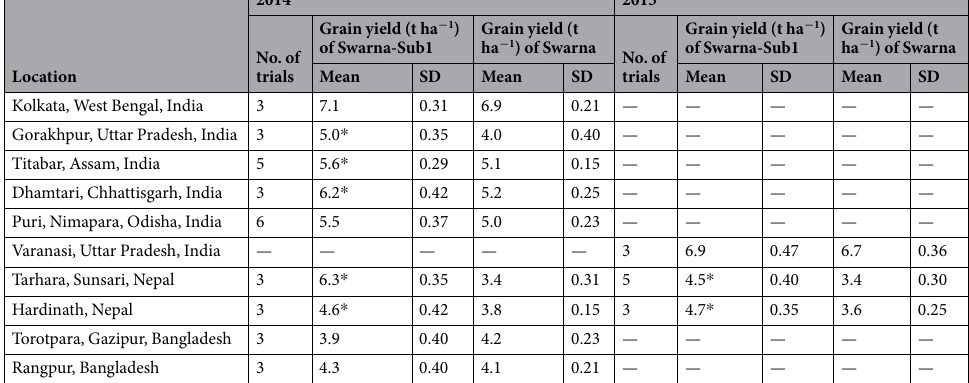
Table 1. Comparisons of grain yield of Swarna-Sub1 and Swarna in head to head trials during the wet seasons of 2014 and 2015. * Indicates that the grain yield is significantly higher than the parental variety at level, p = 0.05.